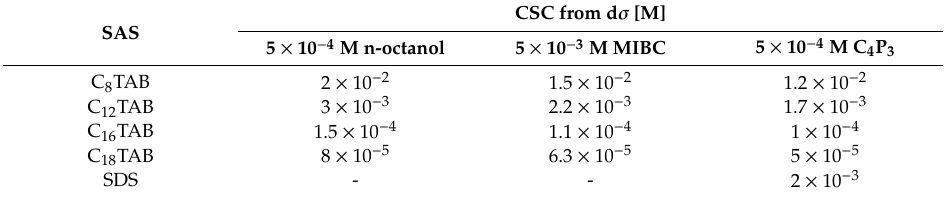
Table 3. Values of critical synergistic concentrations (CSC) calculated from d σ values (see Figure 4b).